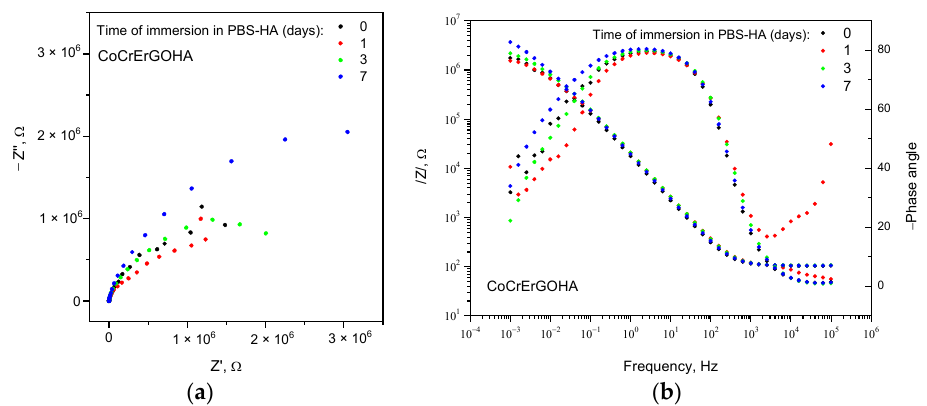
Figure 2. Nyquist ( a ) and Bode diagrams of impedance modulus (( b ) left axis) and phase angle (( b ) right axis) versus frequency for CoCrErGOHA surface in PBS ‐ HA medium with the immersion time.